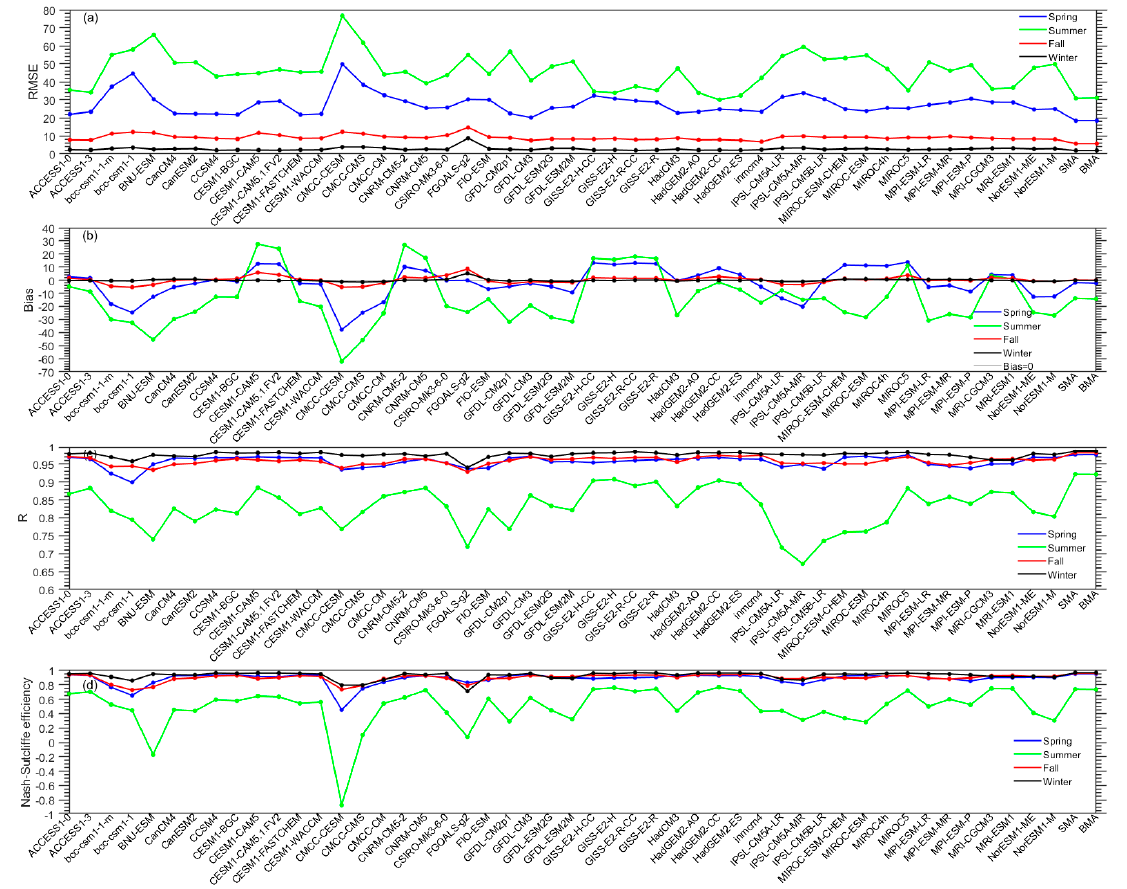
Figure 10. Seasonal statistical results of the SSR simulations from 48 GCMs in CMIP5 with the CERES EBAF retrievals from 2000 to 2005 in the Northern Hemisphere. ( a ) RMSE, ( b ) Bias, ( c ) R, ( d ) NSE (in units of W m − 2 ).